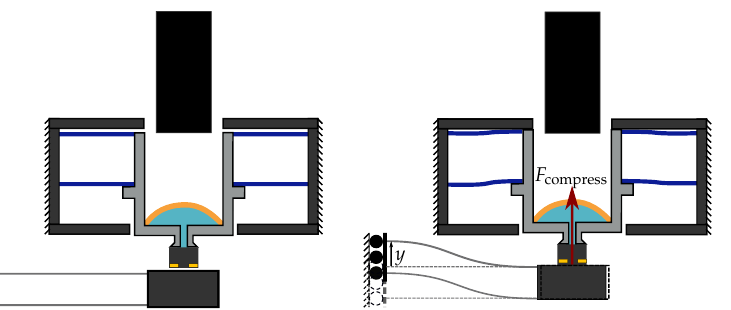
Figure A5. The module for the compression test. A table guided by two parallel beams compresses the component; therefore, applying a known pressure on its surface. This module mimics the industrial electrical testers. In contrast to simple passive capillary grippers, here, the meniscus was sucked into the cavity when the gripper moved up. Performing the compression test in this configuration allowed testing the component without squishing the liquid meniscus, which would result in the total loss of the self-alignment capability. In the case of our gripper, the liquid meniscus could be generated again in the next steps of the process, even though the component has been